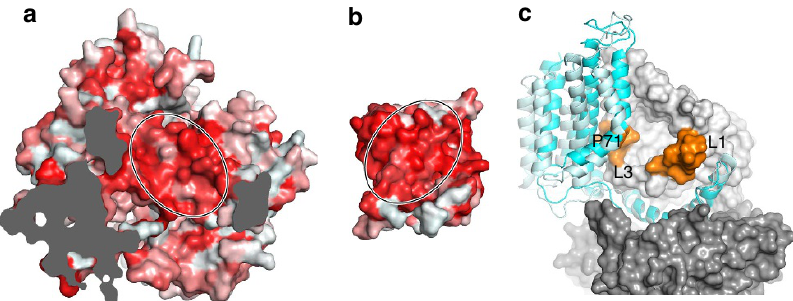
Figure 5 | Sites of interaction between EcfTand FolT2. ( a ) Slice-through of the ECF module in surface representation viewed from the extracellular side of the membrane. FolT2 has been deleted to show the hydrophobic platform on top of the coupling domain of EcfT, indicated by the oval. Colouring according to hydrophobicity, from red (hydrophobic) to grey (hydrophilic). ( b ) Surface of FolT2 interacting with the surface shown in a , using the same colour-coding. ( c ) Structural flexibility in the EcfT subunit. The apo and AMP–PNP-bound structures were superimposed by structural alignment of the ATPase subunits (dark grey surface representation). The resulting positions of the EcfTsubunits are shown in cartoon representation with a viewpoint from the membrane plane. The coupling domains with coupling helices CH1-3 are in almost identical positions in the two complexes, but the membrane domains differ. The membrane domain in the apo -structure (grey) has hinged away compared with the AMP–PNP-bound structure (cyan). Proline 71 on TMH3 of EcfTas well as loops L1 and L3 in FolT2 are shown in